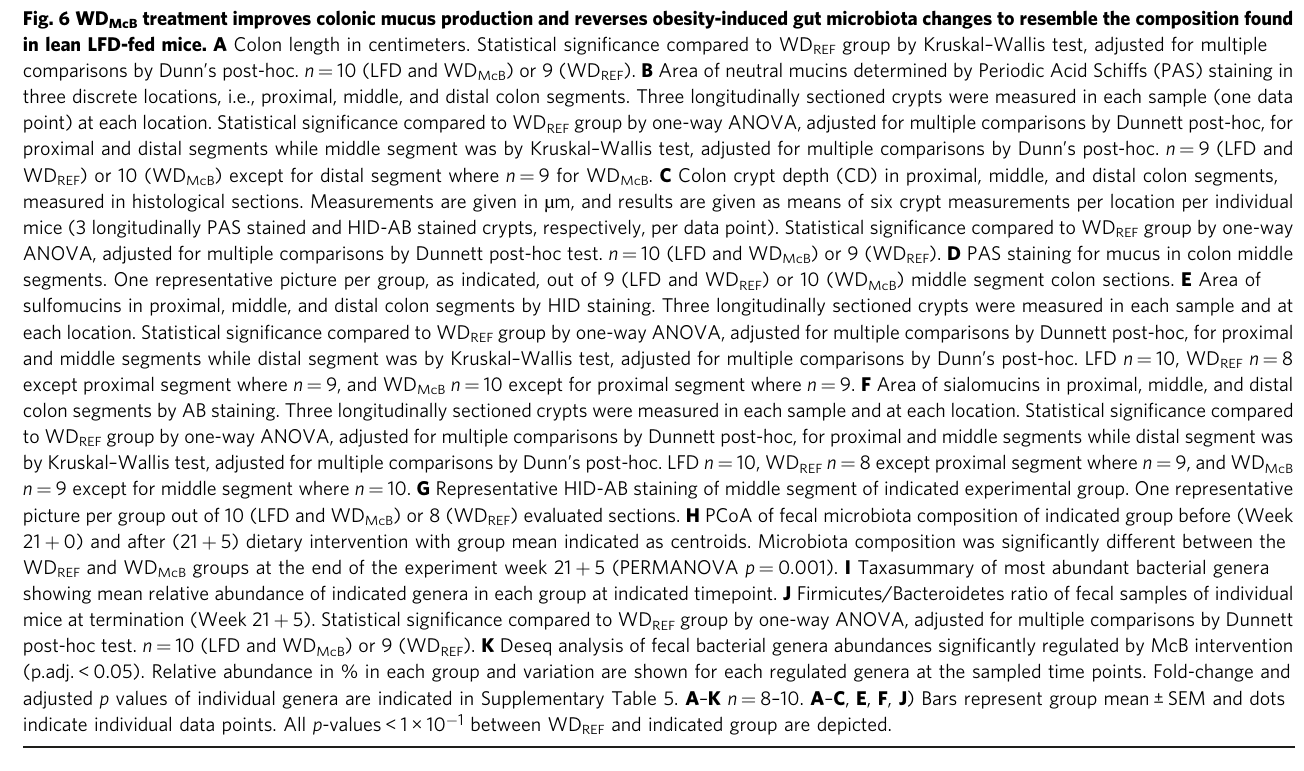
Fig. 6 WD McB treatment improves colonic mucus production and reverses obesity-induced gut microbiota changes to resemble the composition found in lean LFD-fed mice. A Colon length in centimeters. Statistical signi fi cance compared to WD REF group by Kruskal – Wallis test, adjusted for multiple comparisons by Dunn ’ s post-hoc. n = 10 (LFD and WD McB ) or 9 (WD REF ). B Area of neutral mucins determined by Periodic Acid Schiffs (PAS) staining